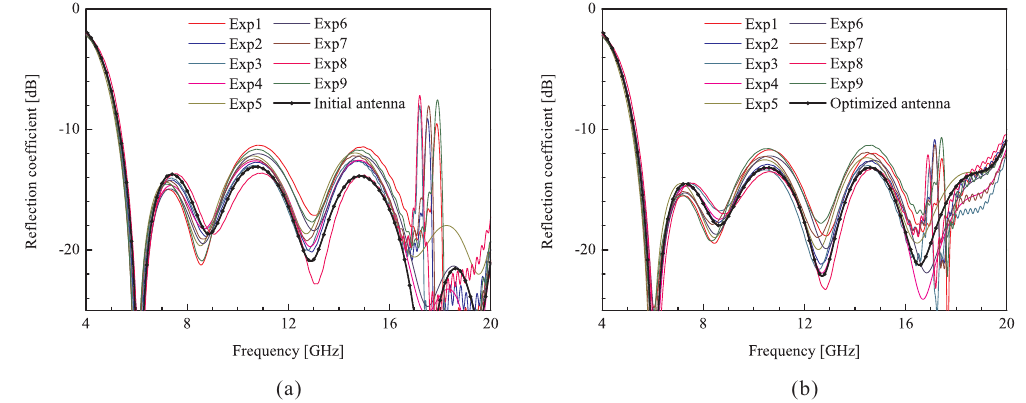
Figure 9. Noise test results of the ( a ) initial and ( b ) optimized TEM horn antennas.